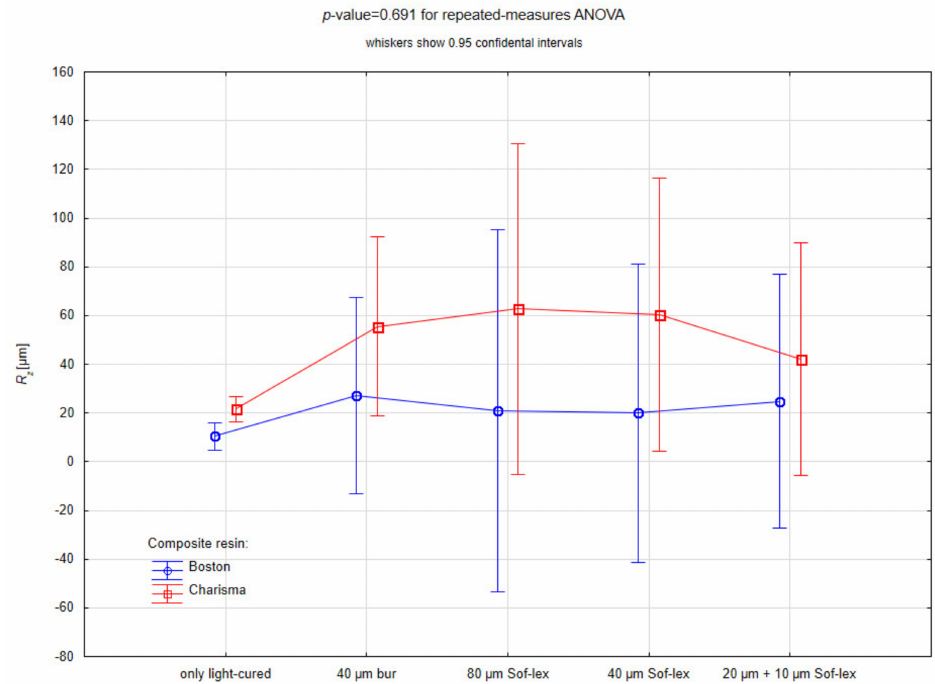
Figure 2. Repeated-measures analysis of variance for R z values in the individual polishing steps depending on the composite resin.